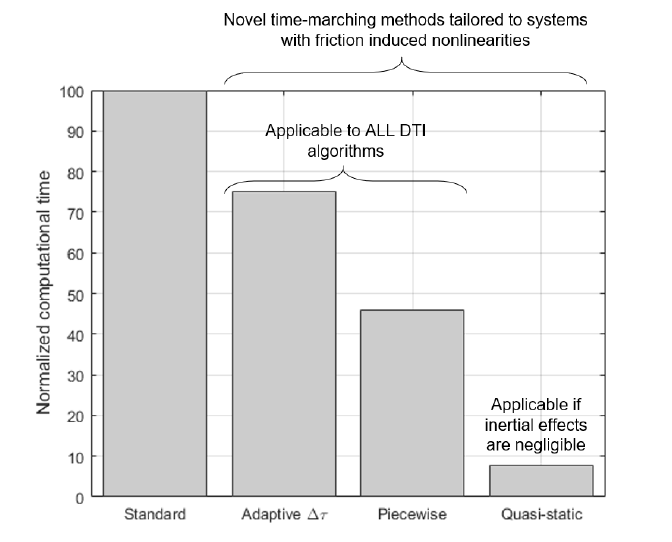
Figure 8. Time savings introduced by the novel techniques and solution methods proposed in the paper. A standard Newmark- β computation is taken as a